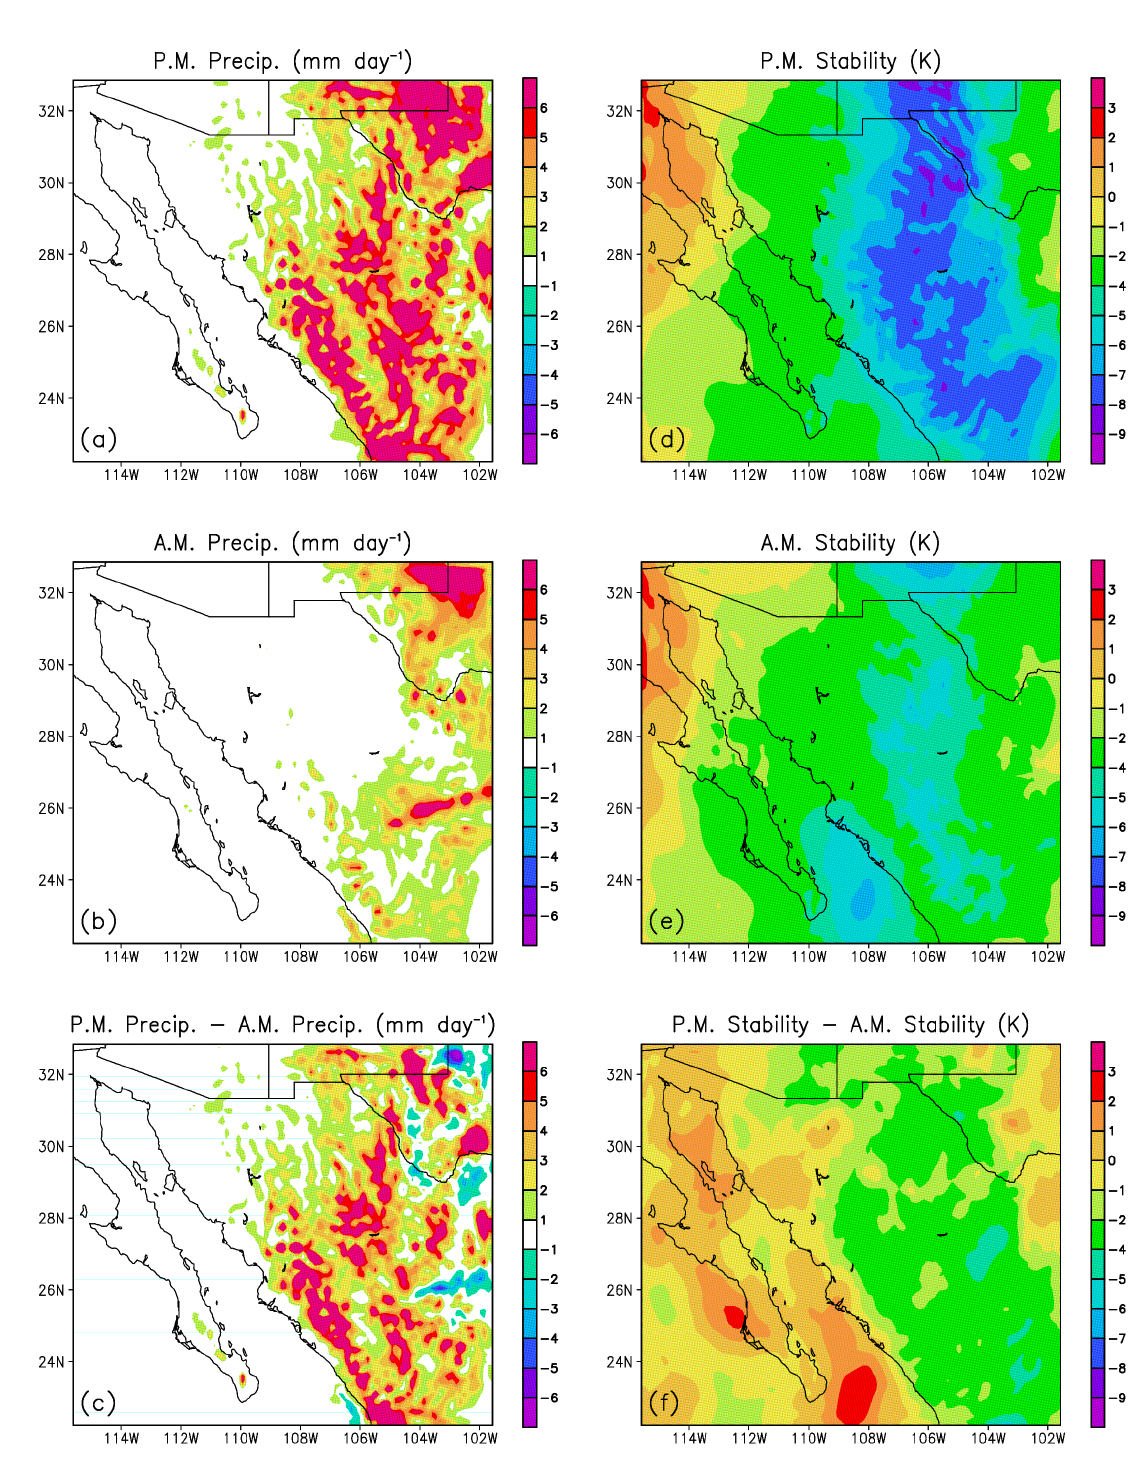
Figure 3. (a)–(c) Precipitation (mm day −1 ); (d)–(f) θ 700